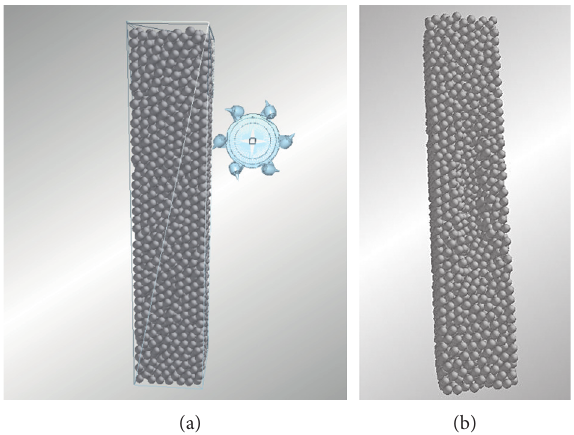
Figure 19: Control group. (a) Coal breaking model. (b) Effect of a certain